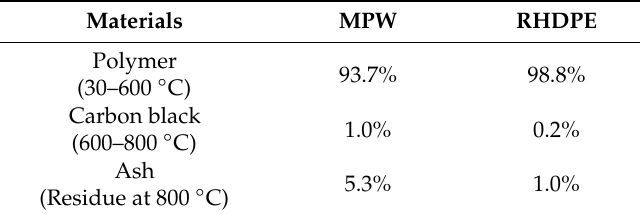
Figure 4. TGA results of raw plastic materials. Table 3. TGA analysis of raw plastic materials.